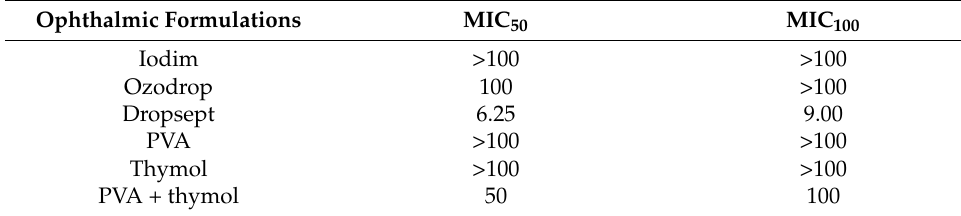
Table 2. S. aureus MIC 50 and MIC 100 .